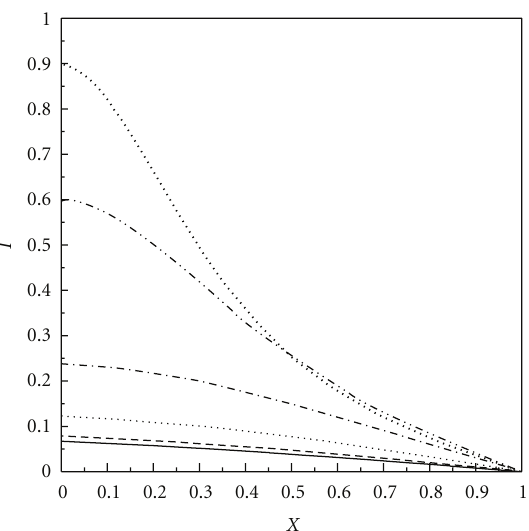
Figure 18: E ffi ciency factor for di ff erent temperature and methanol concentration; l = 10 μ m, a = 1 . 0 × 10 5 m − 1 , κ e = 3 . 4 Ω − 1 m − 1 , D e = 3 . 04 × 10 − 10 m 2 s − 1 , ( (cid:2) ) experiment data, solid line: T = 303K, c 0 M = 1 . 0 M, dash line: T = 333K, c 0 M = 1 . 0 M, dot = 1 . 0 M, dash dot line: T = 333 K, c 0 = 0 . 5 M, line: T = 363 K, c 0 M M = 2 . dash dot dot line: T = 333K, c 0 M